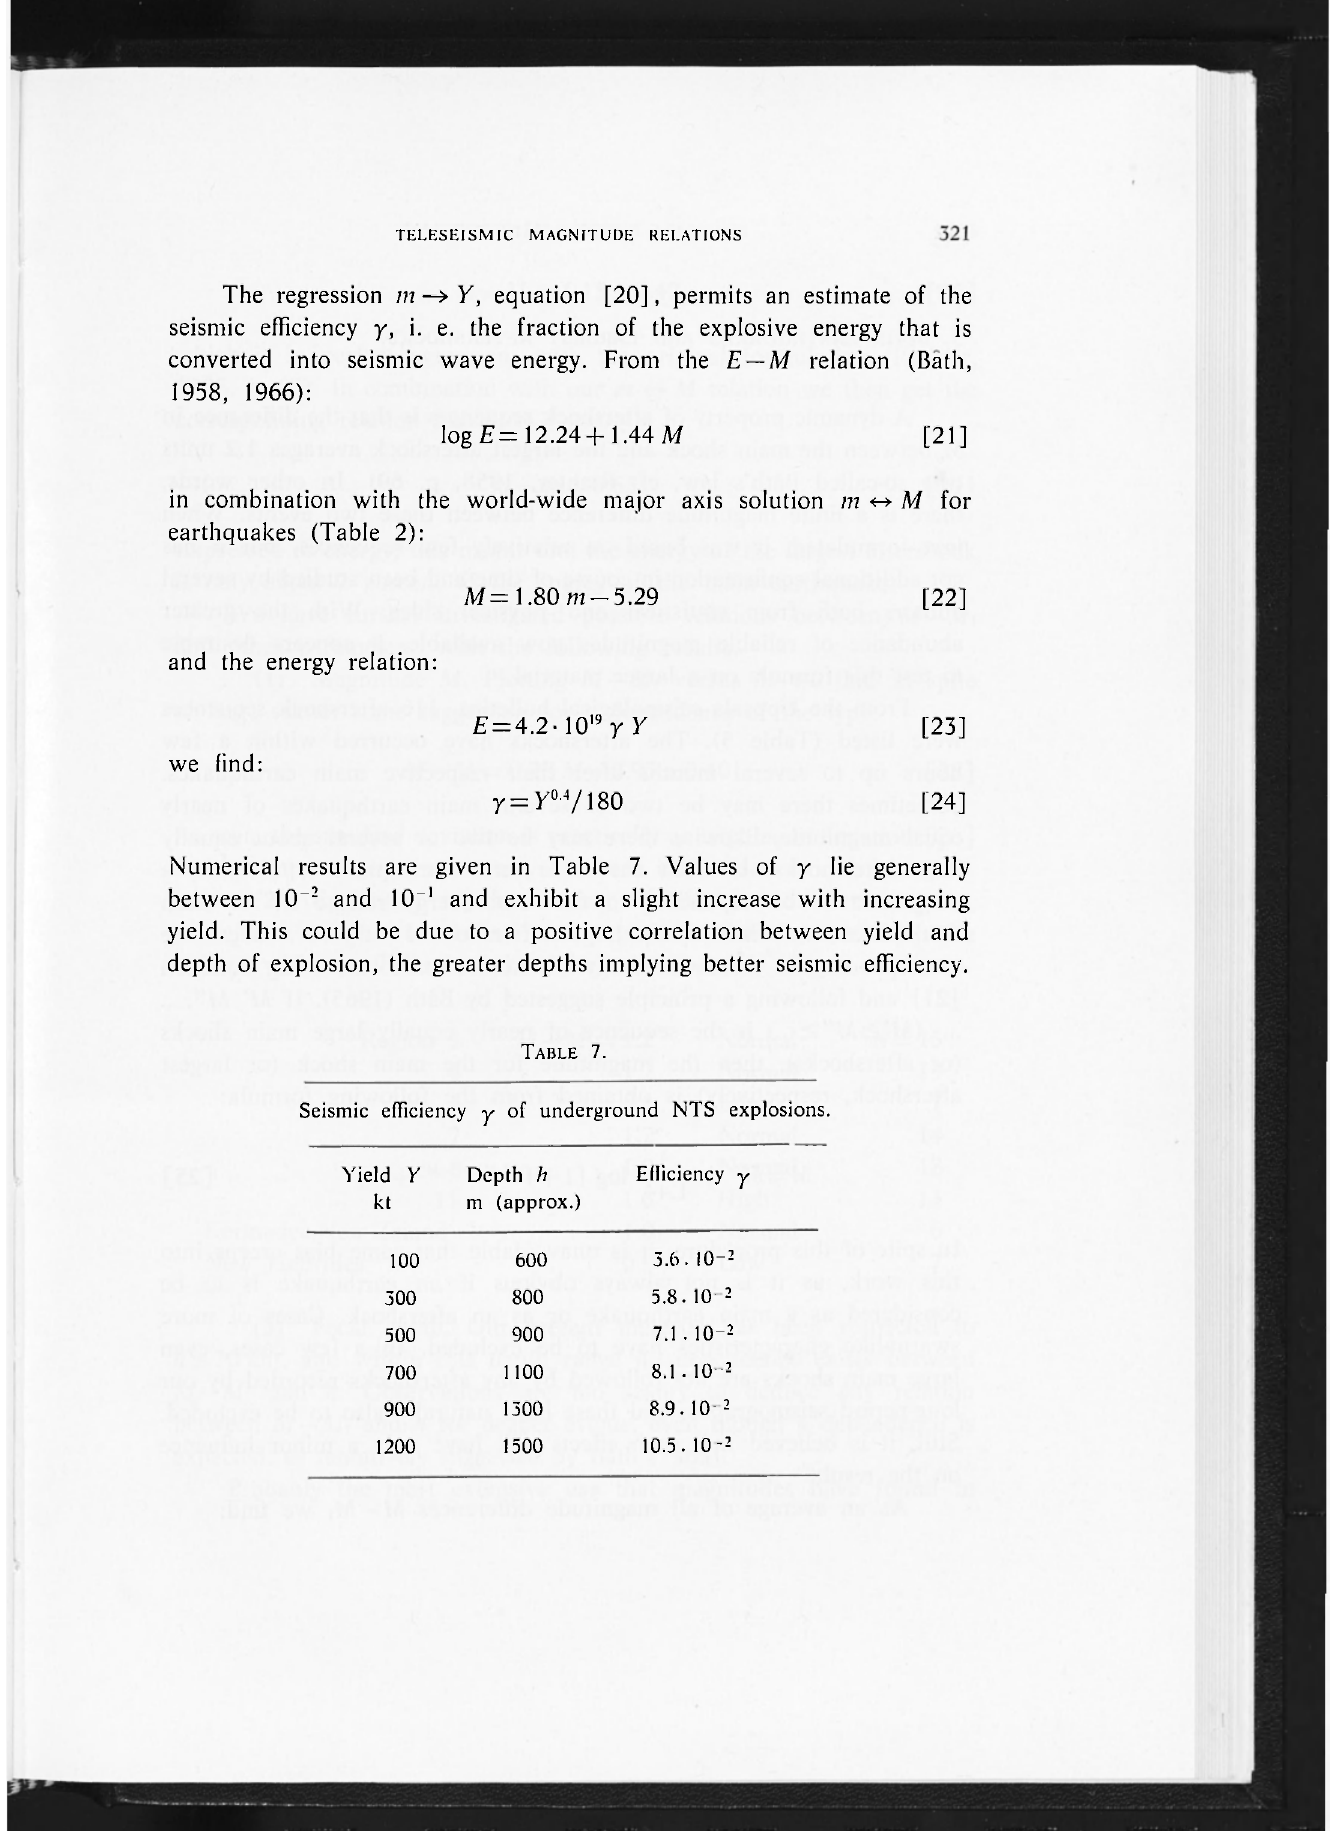
Seismic efficiency y of underground NTS